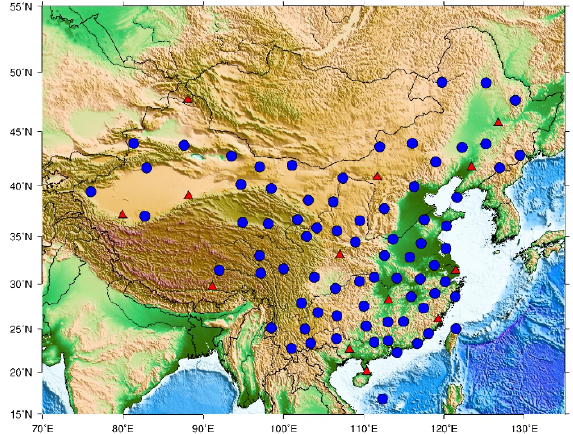
Figure 3. Distribution of selected 89 radiosonde stations in China